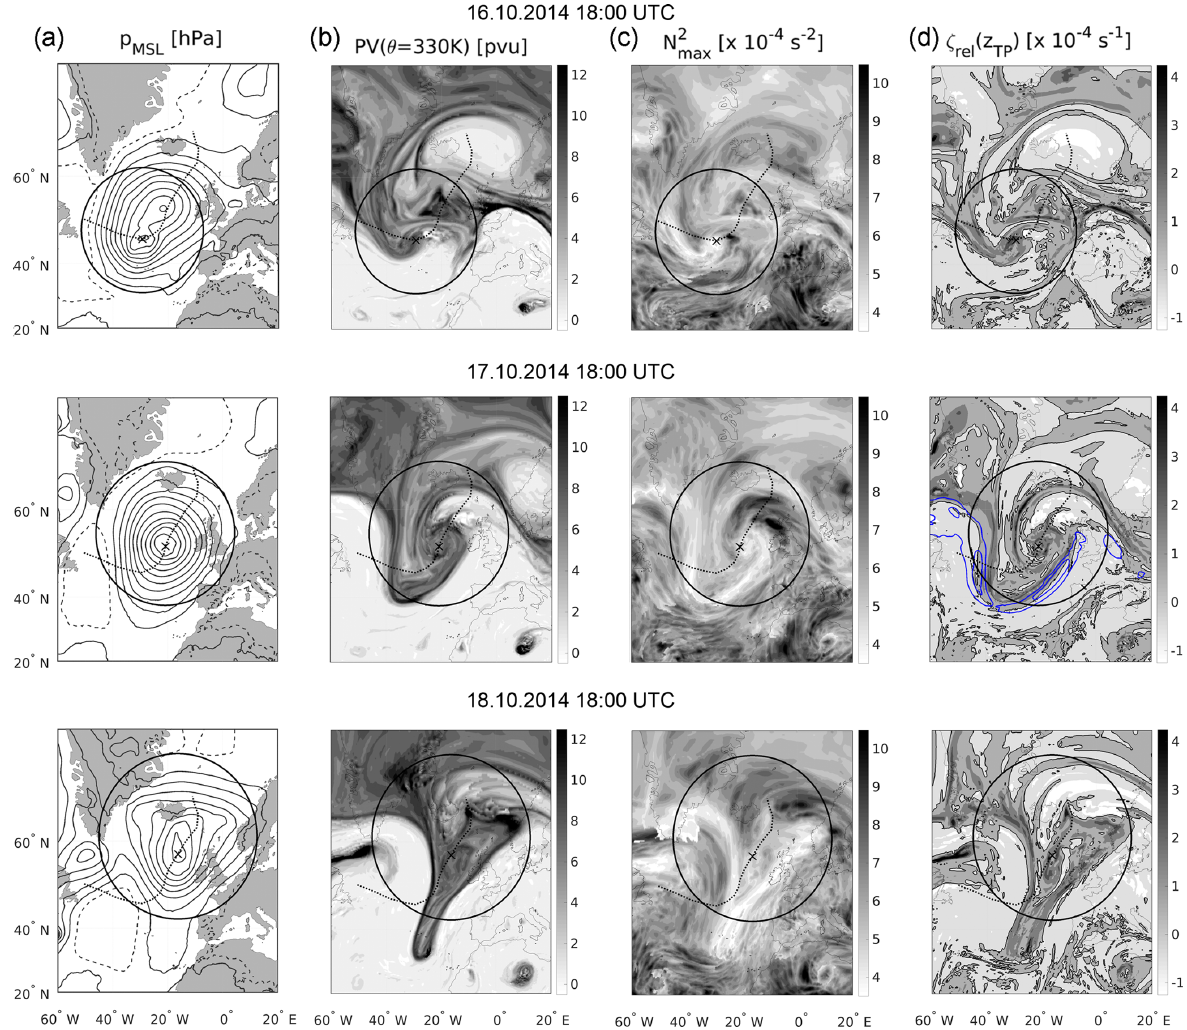
Figure 5. As in Fig. 3, but for the subsequent cyclone with maximum intensity on 17 October 2014 at 18:00UTC, depicted in the middle row. Top row shows 24h earlier and bottom row 24h later.